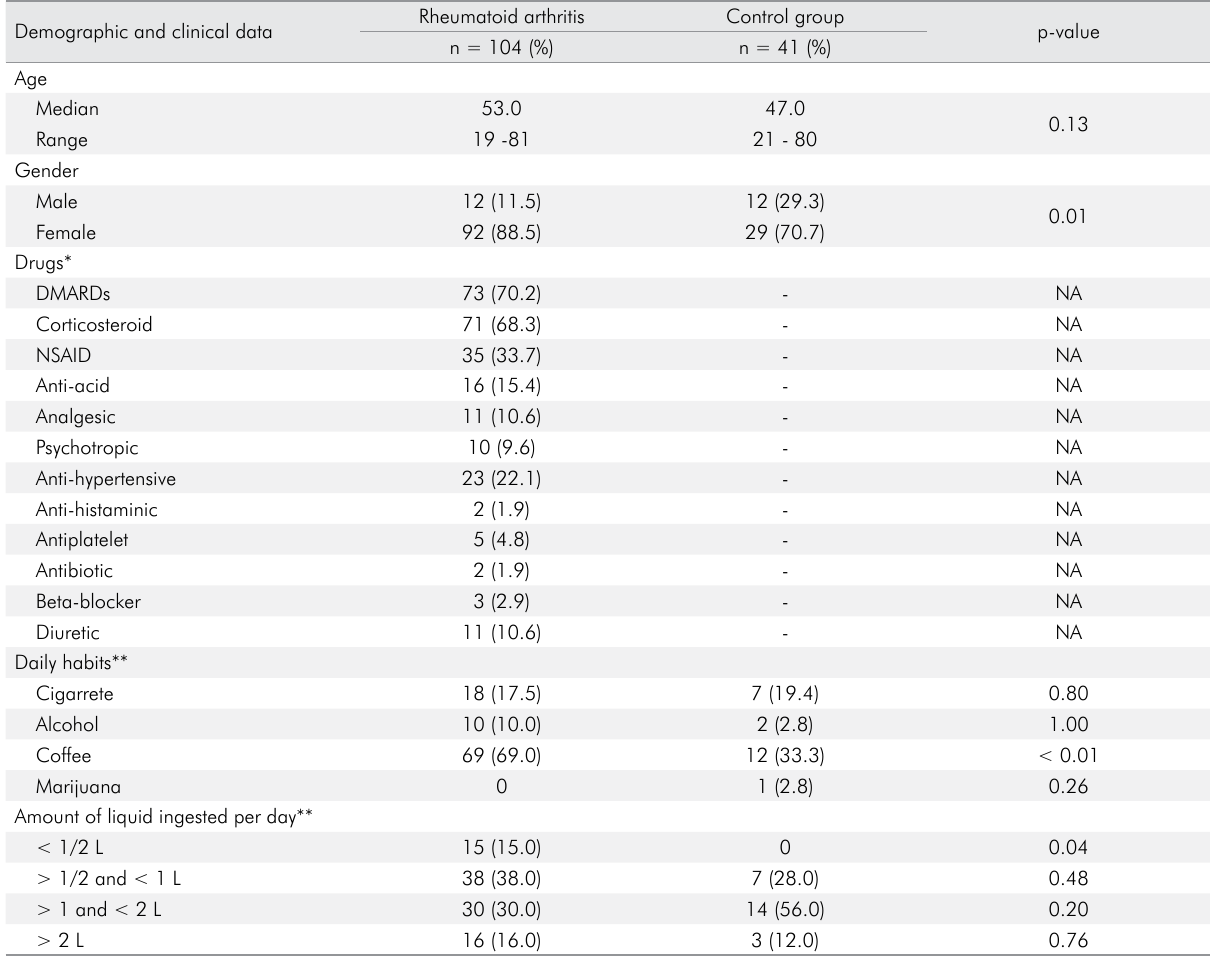
Table 1. Clinical and demographic characteristic of the 145 studied subjects. Demographic and clinical data